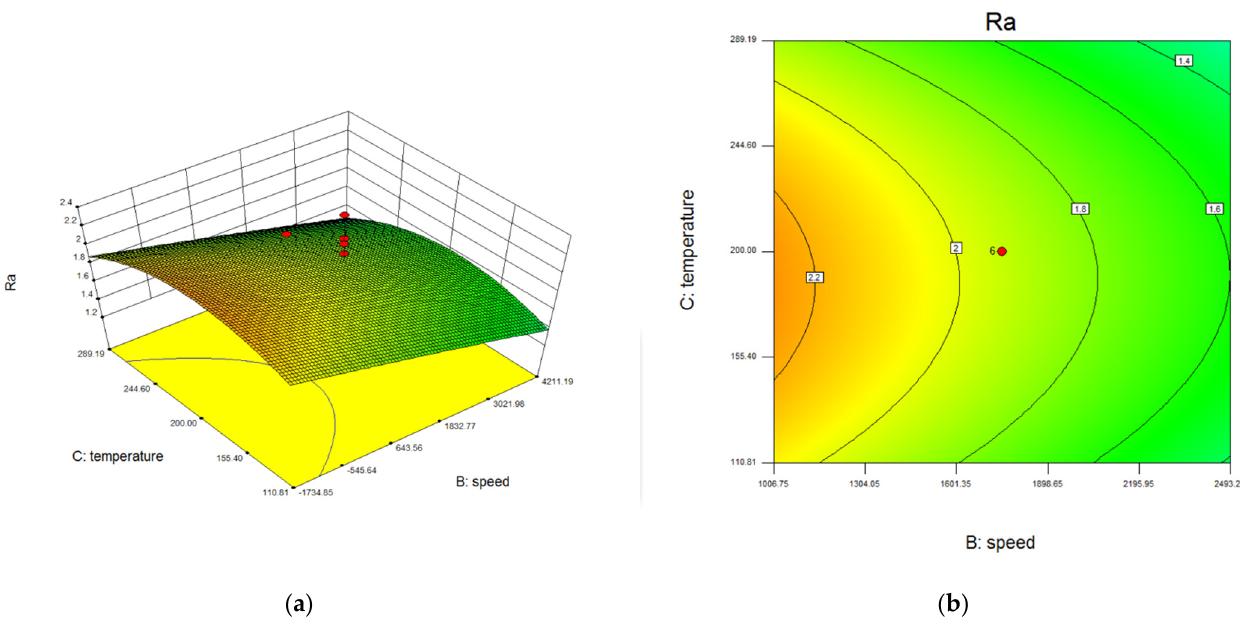
Figure 7. 3D surface plot and contour plot of R a for B and C: ( a ) 3D surface plot; ( b ) contour plot.